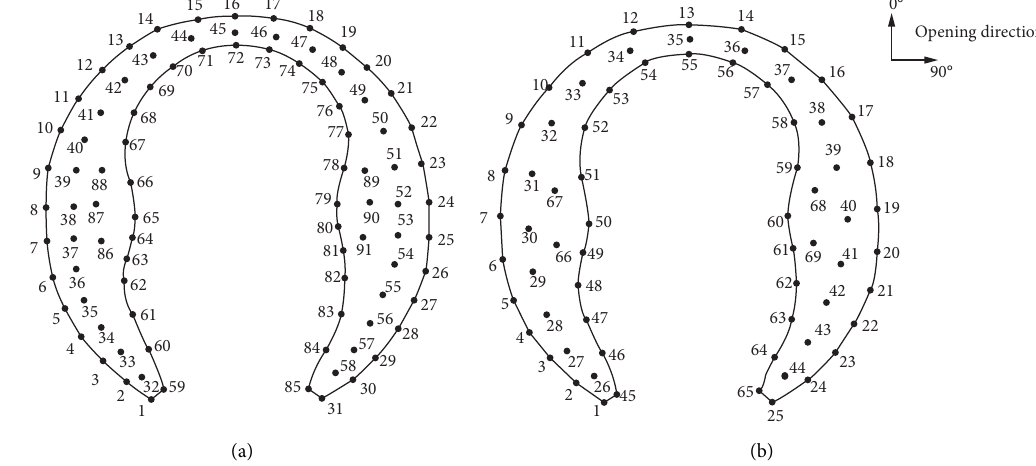
Figure 5: Layout of the stadium monitoring points. (a) 91 measurement points. (b) 69 measurement points.